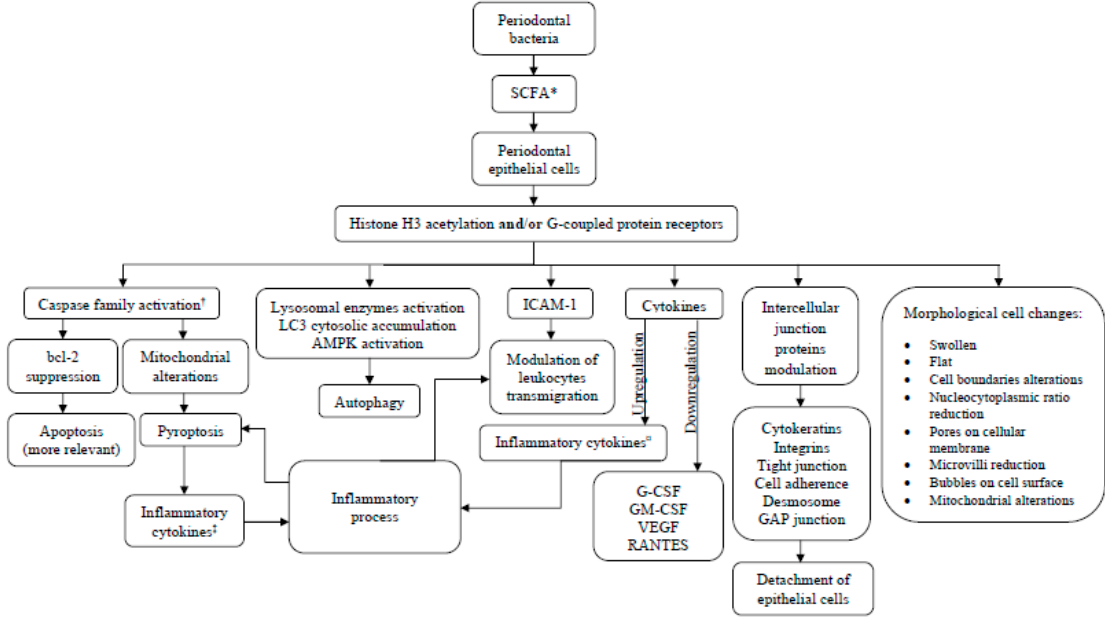
Figure 2. Schematic flowchart of potential molecular mechanisms of SCFA on oral epithelial cells. Cell viability: Cytotoxic effects of SCFA on human oral epithelial cells were evaluated by MTT